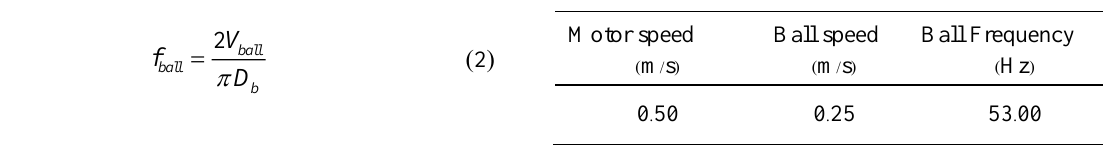
Table 1 . Ball fault characteristic